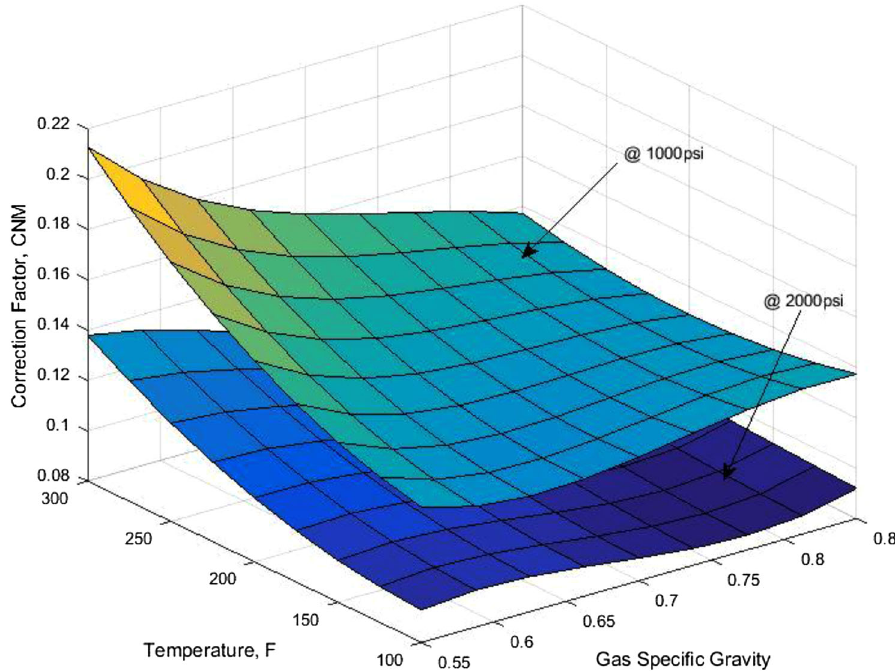
Fig. 12 Isobar plots for natural gases in Table 1 at 1000 and 2000